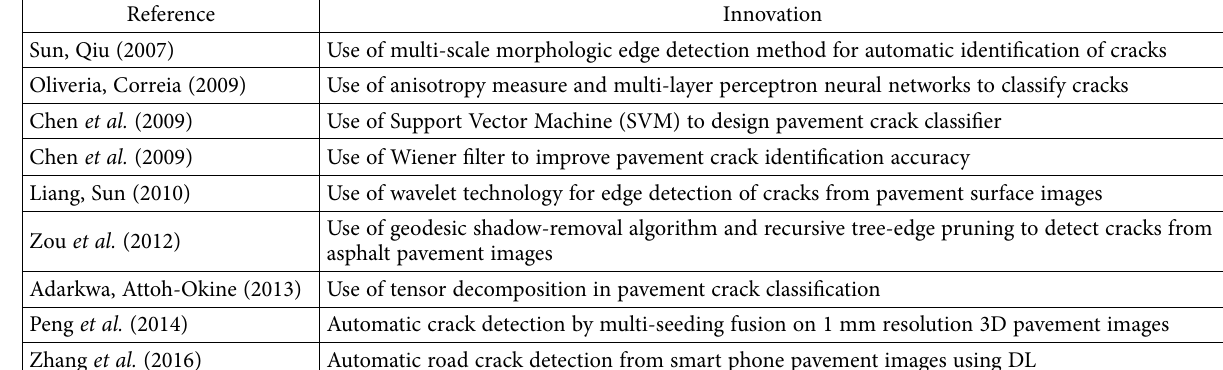
Table 1. Summary of selected recent studies that have focused on the improvement of automated pavement